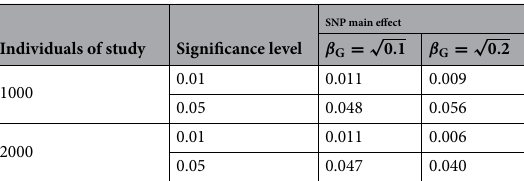
Individuals of study